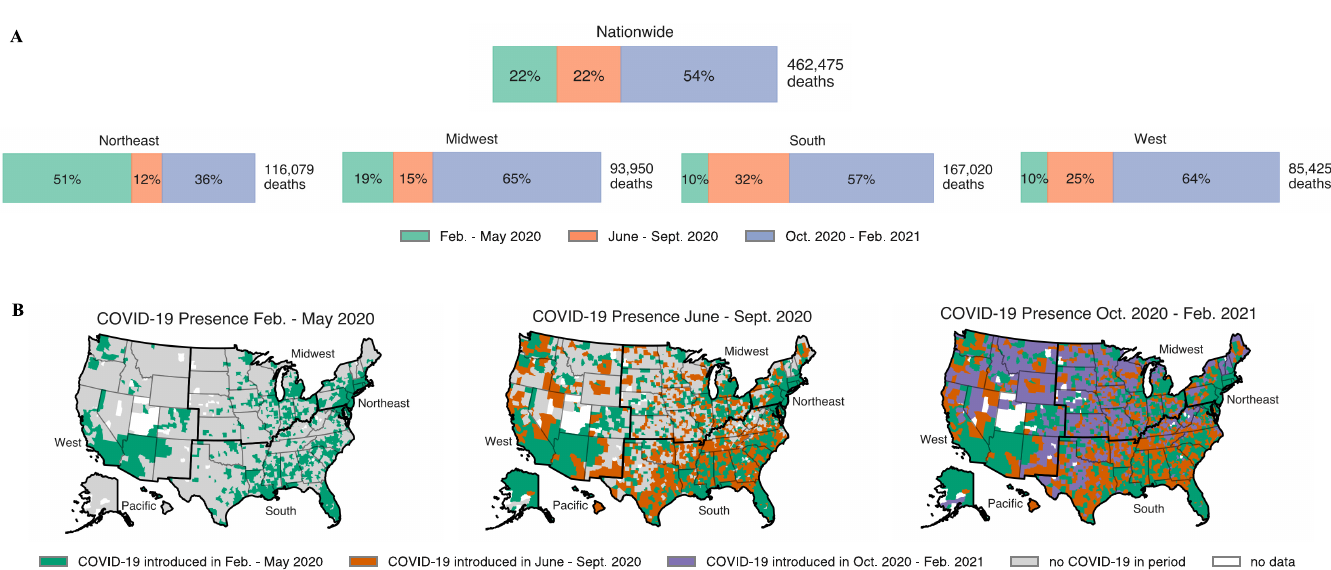
Fig 2. A breakdown of COVID-19 presence across the periods of interest. ( A ) In the top half of the figure, we present the percentage of deaths in the nation by period, both nationwide and by Census region. Other than the Northeast, which was hit hard in the first period, the nation was hit hardest in period 3, as pointed out in [25]. This fact motivates a closer lens on period 3. ( B ) COVID-19 onset at the county level. A county is treated as infected once it has experienced at least 5 COVID-related deaths. We see the movement of COVID from the cities and coastal areas to the center of the county over the course of the year. Counties and regions are plotted using the U.S. Census Bureau’s 2019 shapefiles